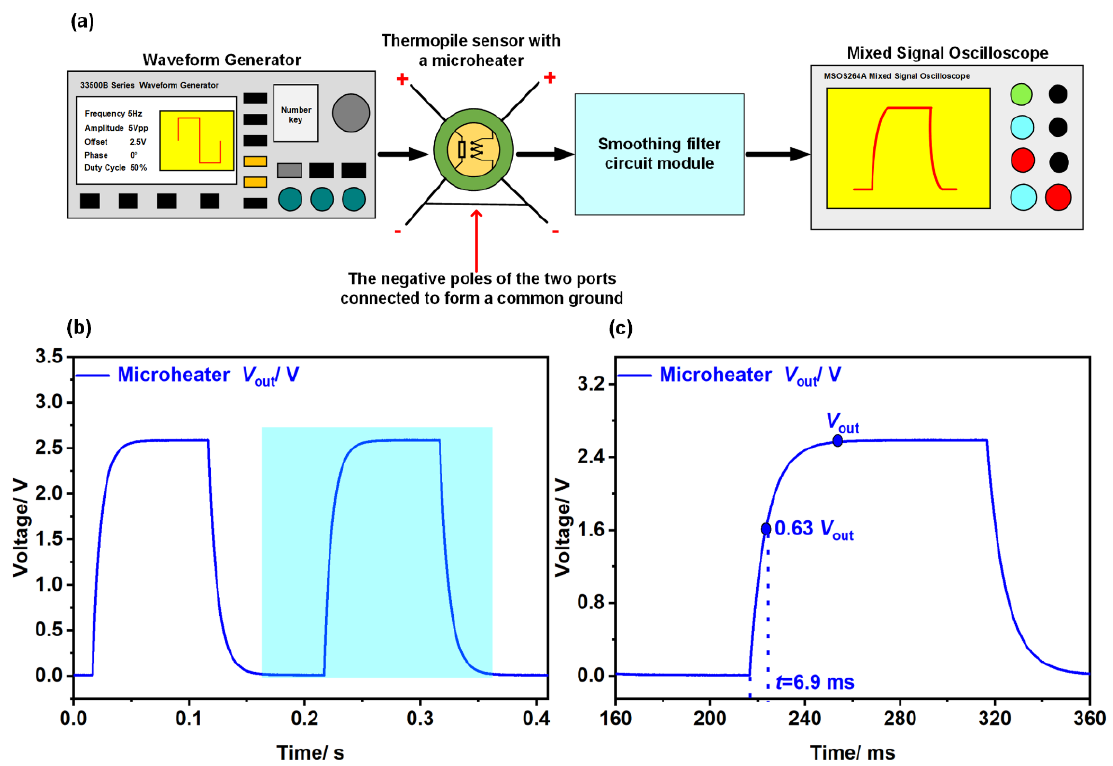
Figure 7. ( a ) Schematic diagram of a microheater — based system; ( b ) output waveform of multiple cycles obtained by the microheater — based system; ( c ) a single cycle illustrating the response time of the device.